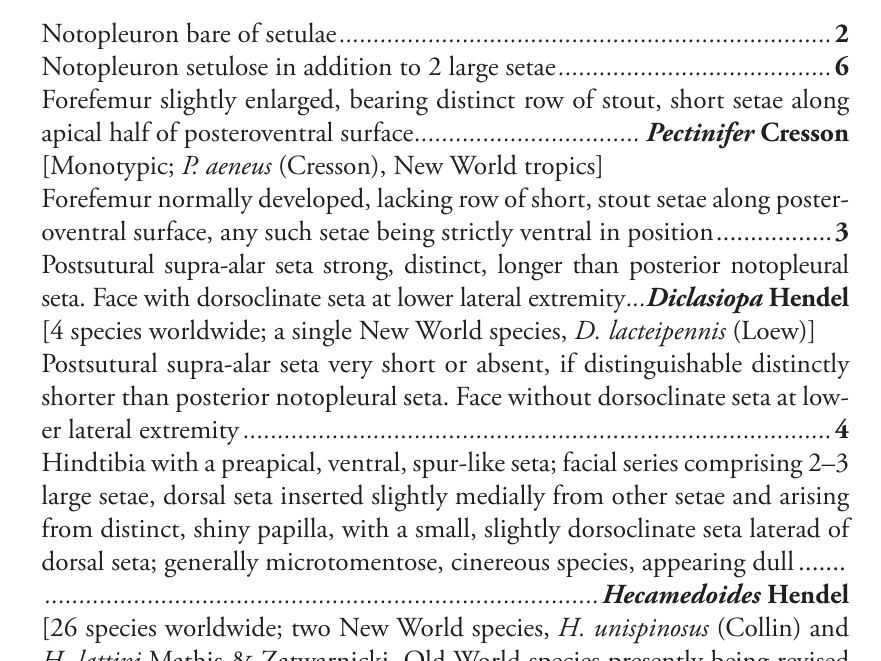
2 large setae, dorsal seta not arising from a shiny papilla and lacking a smaller